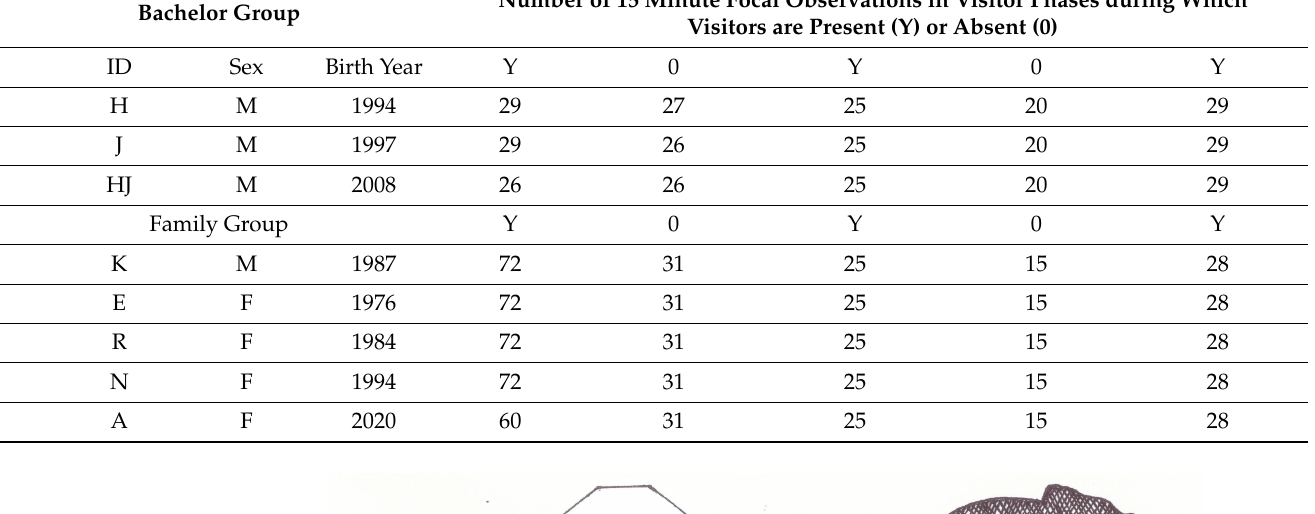
Table 1. Gorilla IDs, sex, birth year, and number of observations in each visitor phase. Number of 15 Minute Focal Observations in Visitor Phases during Which Visitors are Present (Y) or Absent (0)